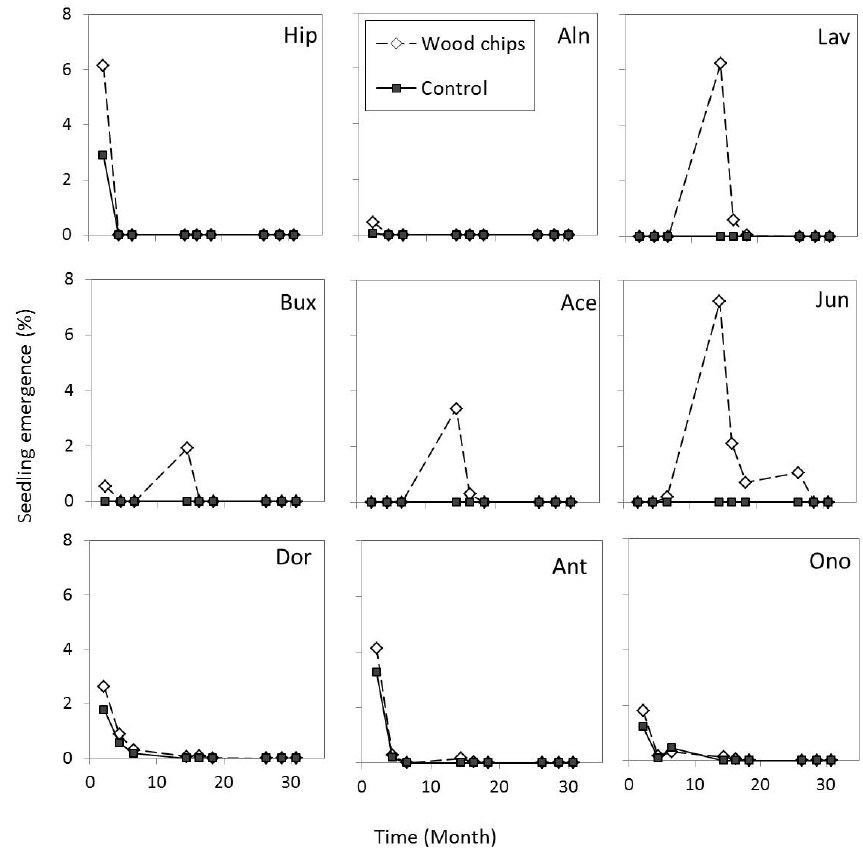
Figure 7. Effect of wood chips and comparison between species on seedling emergence for three growing seasons after seeding (see species abbreviations in Table